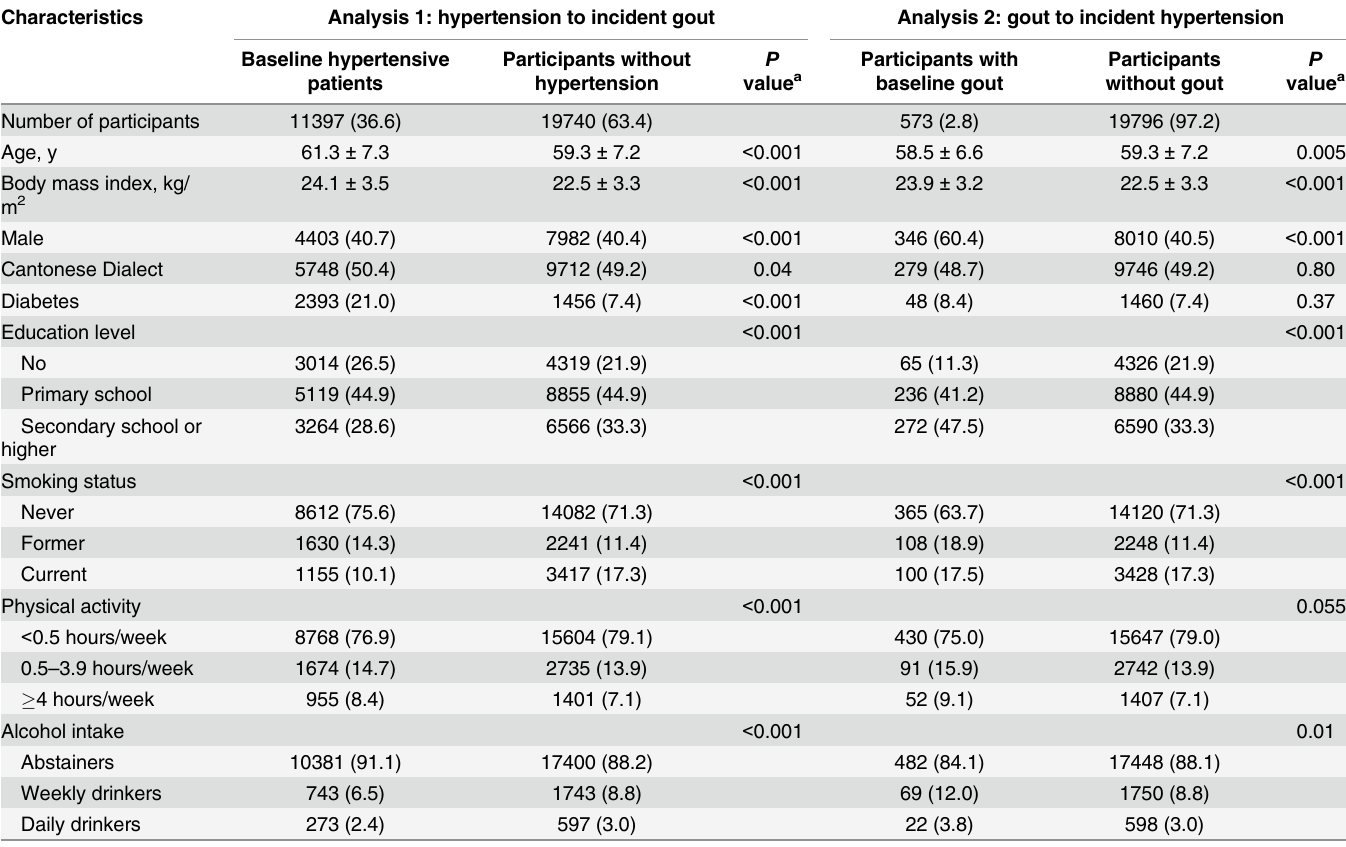
Table 1. Characteristics of cohort participants at follow-up I interview (1999 – 2004) in the two analyses: The Singapore Chinese Health